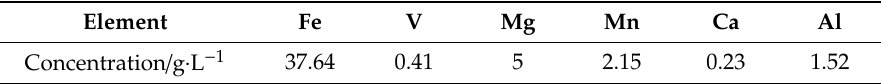
Table 1. Composition of titanium dioxide waste acid used in the experiment. Element